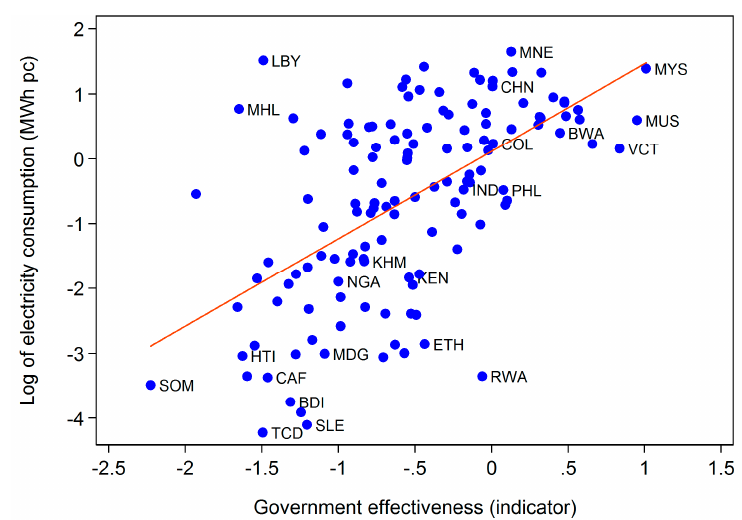
Figure 2. Government effectiveness and log of final electricity consumption (megawatt hours per capita). Data are unavailable for some small countries. The most populous country for which data are unavailable is Eritrea. Sources: [2,38,39].